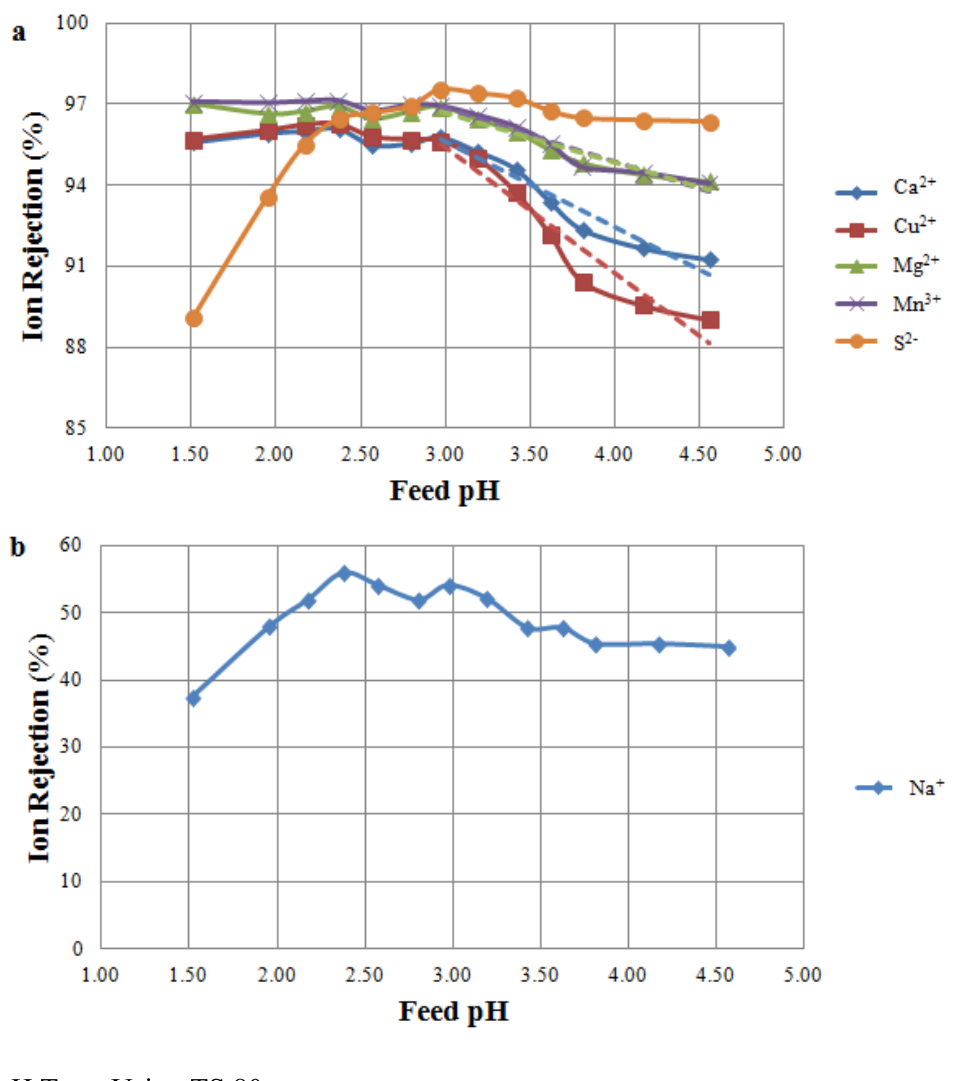
Figure 3. Ion rejection at varying feed pH as a result of the MW Tests. Tested feed solution: MW A. Tested membrane: NF 270 membrane. (a) Rejection of multivalent ions. Significant (p-value < 0.05) decreasing trends of cation rejections are shown for a pH higher than three; (b) Rejection of sodium